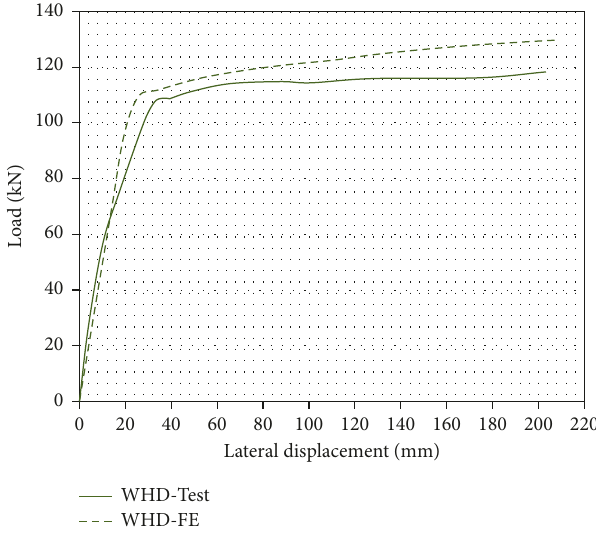
Figure 11: Load-deflection verification curve of test versus FE (specimen WLD).